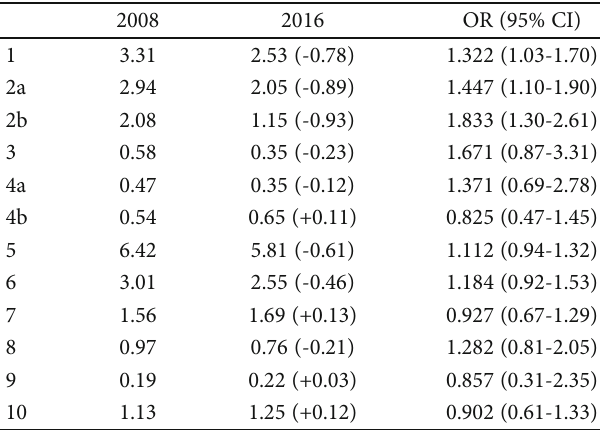
Table 4: Robson ’ s 10-Group Classi fi cation of Flemish women giving birth in 1992-2000-2008-2016: cesarean sections per group (%). ND = no data.